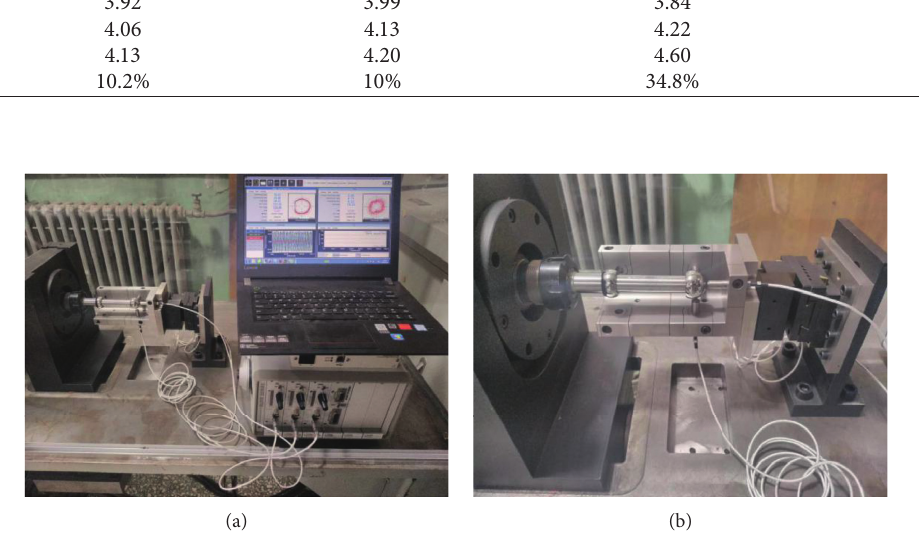
Figure 9: The test equipment of hydrostatic spindle revolution accuracy.